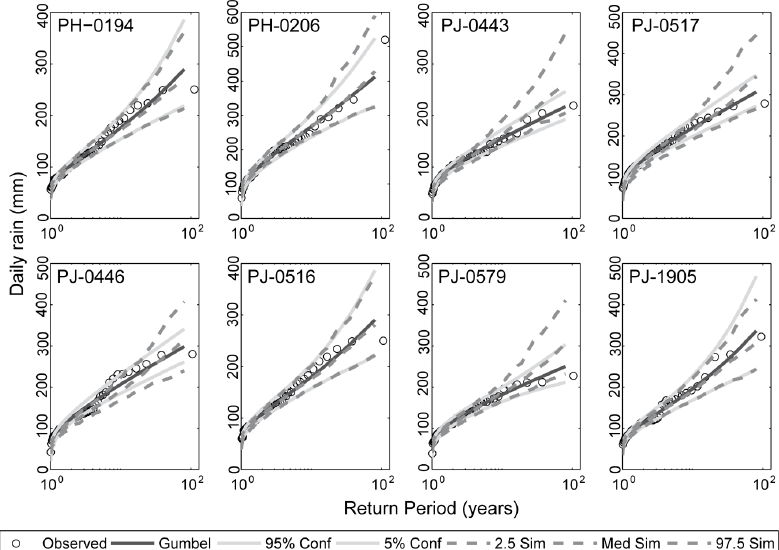
Figure 9. Frequency curves of the AMR for the eight rain gauges selected: observed data (circles); fitted distribution to observed data (solid line) with its 95% confidence interval (dotted line); and median of the 300 62-year series obtained from the simulation series with its 2.5% and 97.5% percentiles (dotted-dashed lines). Table 4. NSE values calculated for the AMR for the eight rain gauges.